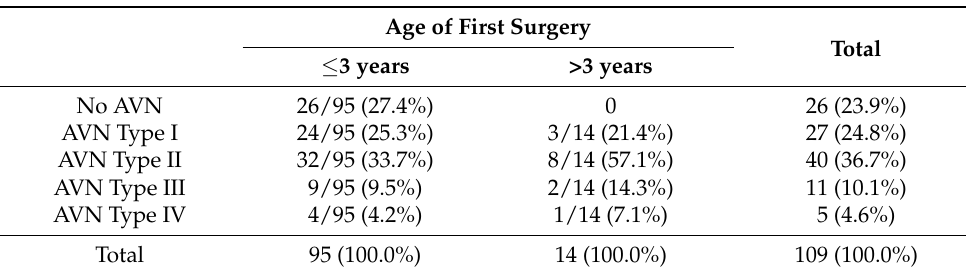
Table 2. AVN distribution in patients who had their first operation at less than or equal to 3 years of age and greater than 3 years of age.